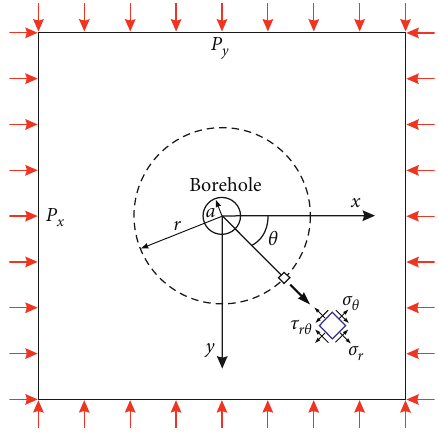
Figure 6: Sketch of applying in situ